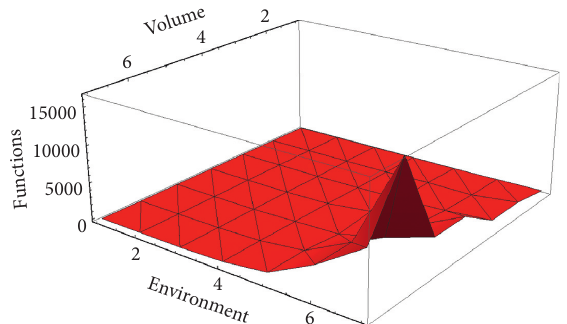
Figure 8: Number of functions over environment thicknesses and volume sizes for rule 90 (Class D). This is also one of the exceptional rules. Note the pronounced maximum at environment thickness 7 and volume size 6.